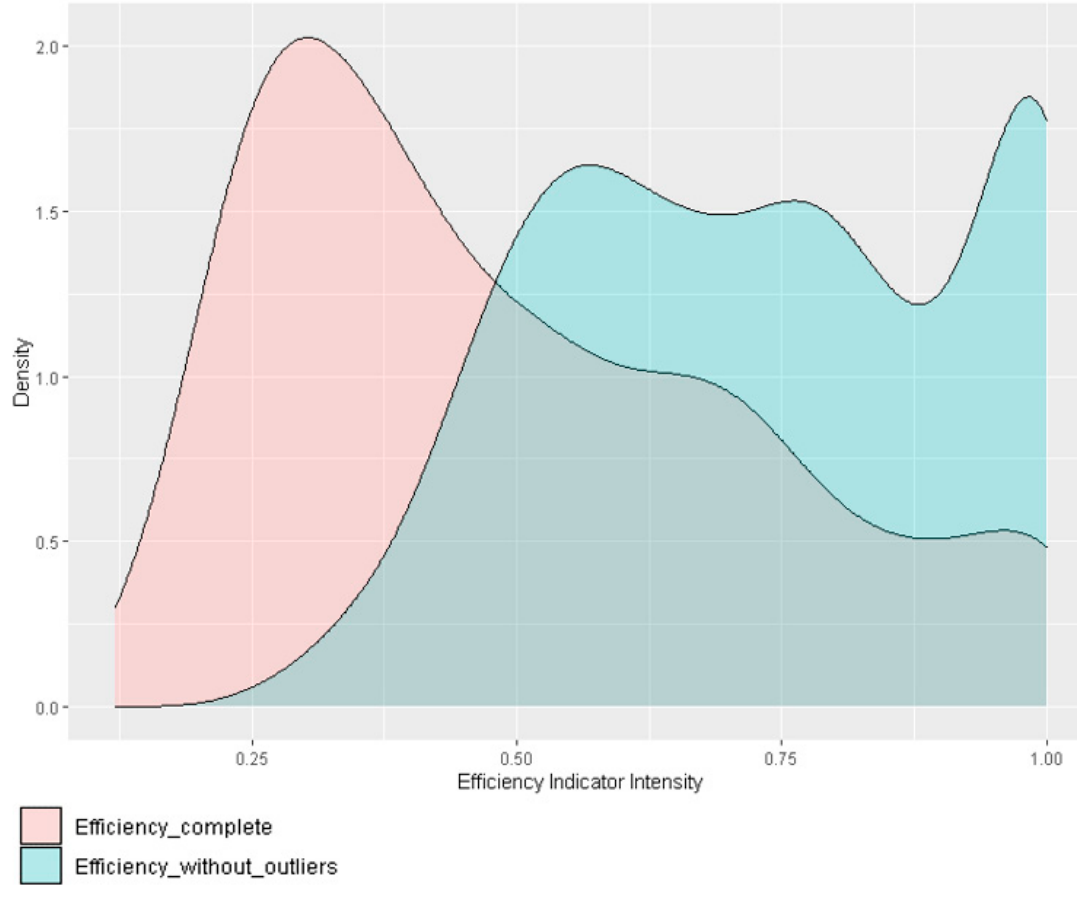
Figure 1. Density of the DEA-CRS efficiency. (Source: formulated by the authors).